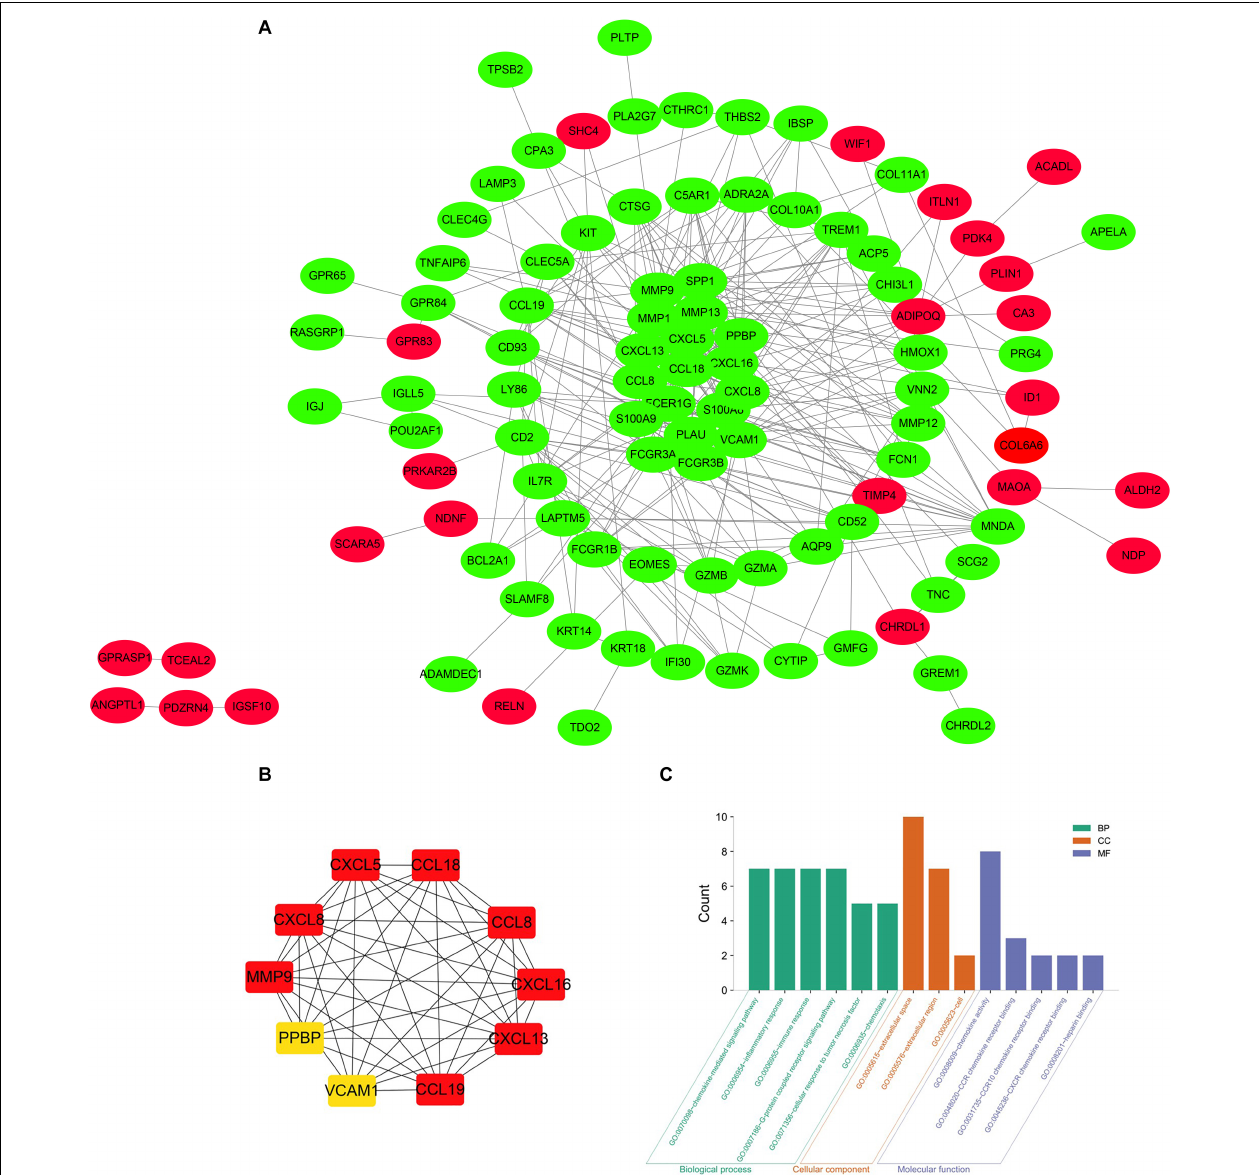
FIGURE 4 | (A) The PPI network of DEGs identified from the two microarray datasets was constructed using Cytoscape, including 49 up-regulated genes and 95 down-regulated genes. The upregulated genes are marked in red and downregulated genes are marked in green. (B) The top 10 most significant genes were obtained from PPI network. DEG, differentially expressed gene; PPI protein, protein interaction. (C) The top 10 most significantly enriched GO terms of